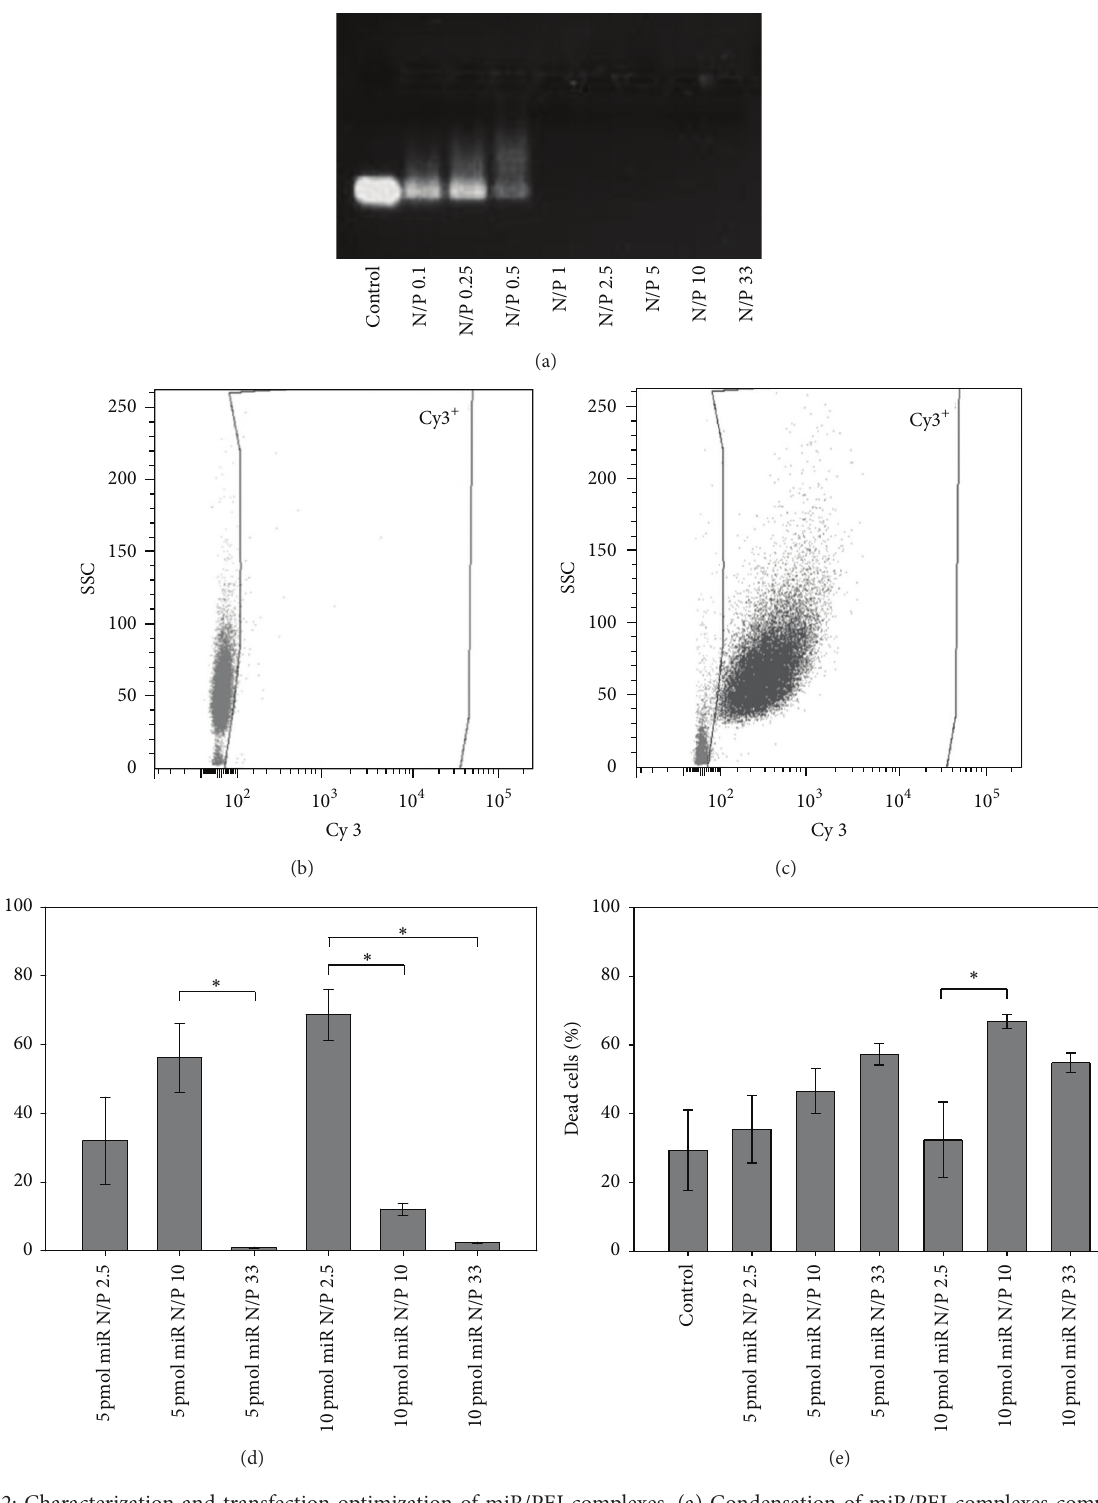
Figure 2: Characterization and transfection optimization of miR/PEI complexes. (a) Condensation of miR/PEI complexes composed of 20 pmol miR and different N/P ratios (ranging between 0.1 and 33) was analysed by gel electrophoresis. miR alone served as positive control. ((b), (c)) Gating strategy of FACS measurements. (b) Untransfected living CD105 + cells were used as negative control. (c) Living CD105 + cells transfected with Cy3-labeled complexes. ((d), (e)) Optimization of miR amounts and N/P ratios for transfection of freshly isolated hMSCs. hMSCs were transfected with Cy3-labeled miR/PEI complexes consisting of three different N/P ratios (N/P 2.5, N/P 10, and N/P 33) and two different miR amounts (5 and 10pmol). 24 hours after transfection, uptake efficiency (d) and cytotoxicity (e) of complexes were analyzed by flow cytometry. Untransfected cells were used as control. Values are presented as mean ± SEM; 𝑛 = 3 ; ∗ = 𝑃 ≤ 0.05